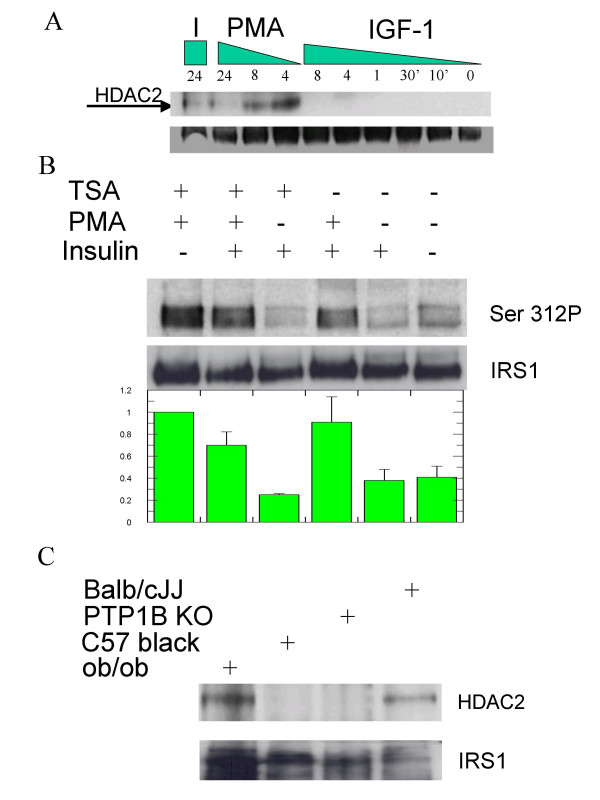
Analysis of conditions for interaction between IRS-1 and HDAC2 in mammalian cells and tissues. A: MCF-7 human breast carcinoma cells were treated with 10 ng/ml IGF-1 ("I") or 10 ng/ml PMA for the indicated times. IRS-1 was immunoprecipitated from cell lysates and western blots were analysed for co-immunoprecipitation of HDAC2. The upper gel shows presence of HDAC2 whilst the lower gel is a loading control for IRS-1. The data are representative of multiple experiments. Similar data are obtained if IGF-1 is exchanged for 100 nM insulin. B: MCF-7 cells were treated PMA (10 ng/ml) or TSA (150 ng/ml) for 4 hours prior to stimulation with or without insulin (100 nM) for 10 minutes, lysis and immunoprecipitation of IRS-1. Western blots were probed for the presence of phospho-serine 312 in IRS-1 (upper gel) and IRS-1 (lower gel). The histogram shows the means ± range for results for serine 312 phosphorylation from two independent experiments, normalised to the maximum phosphorylation signal, which was seen in cells treated with PMA and TSA. In separate control experiments, we have seen that the phosphorylation of serine 312 in cells is driven by PMA and that TSA does not contribute to the effect (data not shown). C: Liver tissues from ob/ob mice, c57/bl6 mice, PTP1B knockout mice and balb/cjj mice were prepared as described in the Methods section and IRS-1 was immunoprecipitated. Western blots were analysed for the presence of HDAC2 (upper gel) or IRS-1 (lower gel). Each lane is from one mouse and is representative of at least two other animals per group.